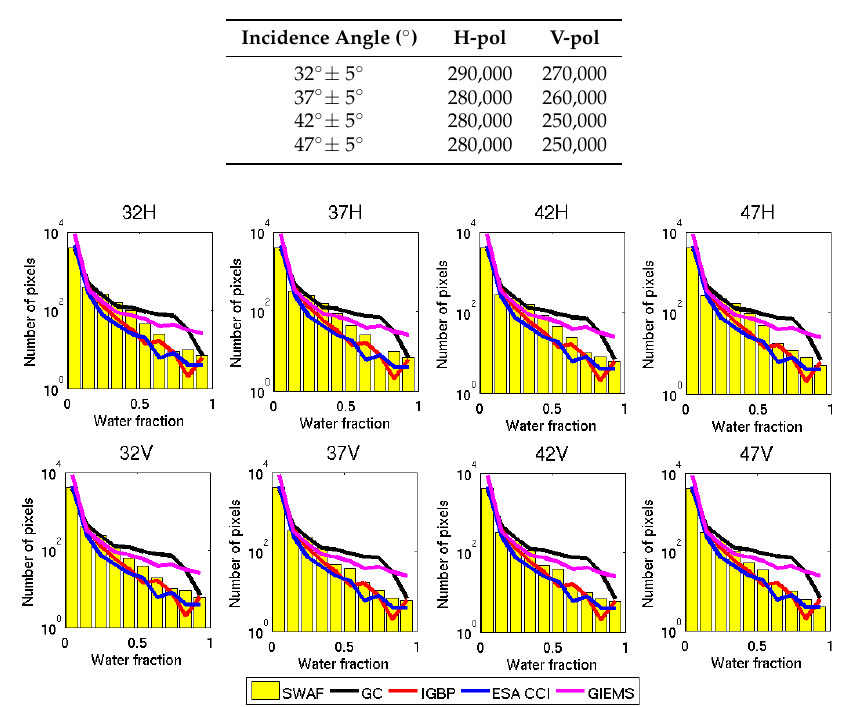
Table 3. Average of the number of square kilometers flooded in the Amazon Basin for the eight SMOS configurations.